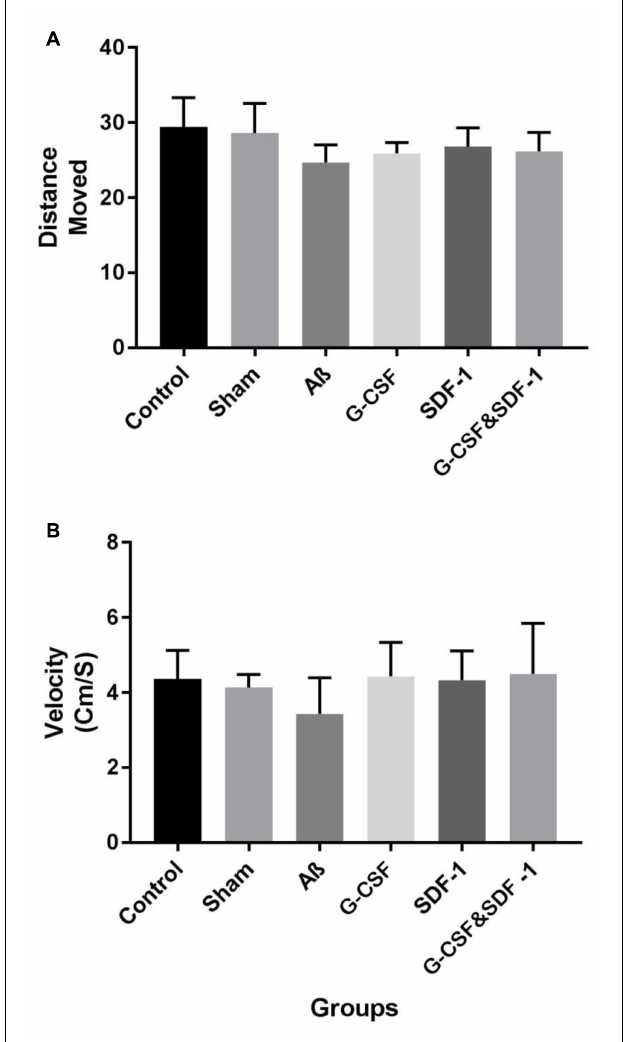
FIGURE 2 | Effect of treatment in A β rat model on distance move (A) and velocity (B) in open field test. Data are represented as Mean ± SEM.